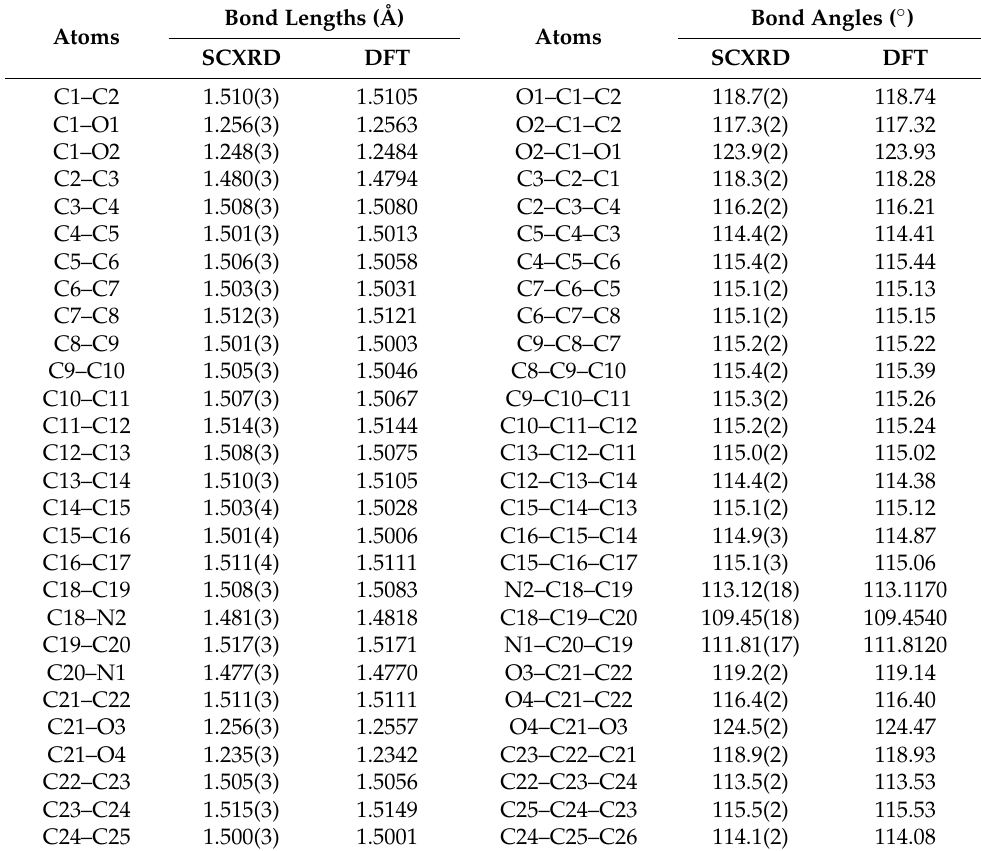
Table 3. Bond lengths (Å) and angles ( ◦ ) for